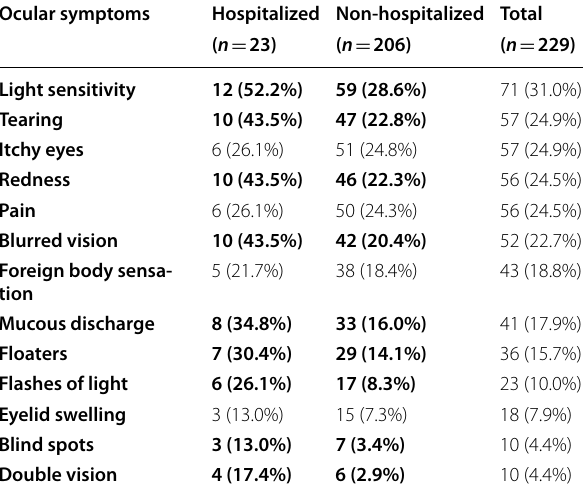
Table 3 Ocular symptoms reported by survey participants. hospitalized ocular symptoms are displayed in bold